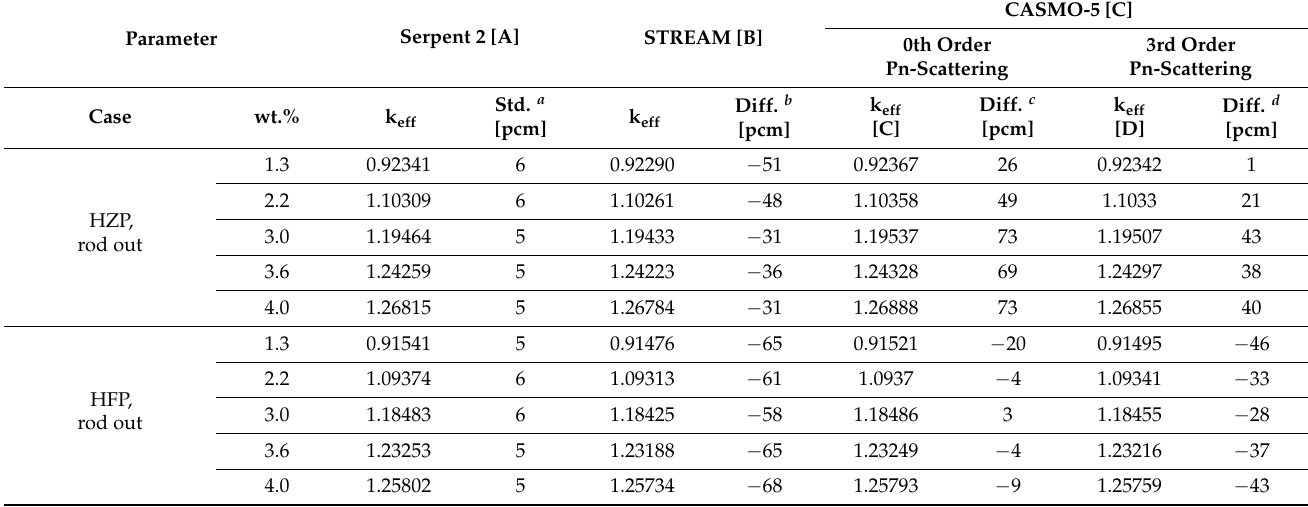
Figure A1. Calculation difference between STREAM and STREAM/RAST-K (calculation model: U22, burnup: 20 MWd/kg). Table A1. Multiplication factor in various calculation